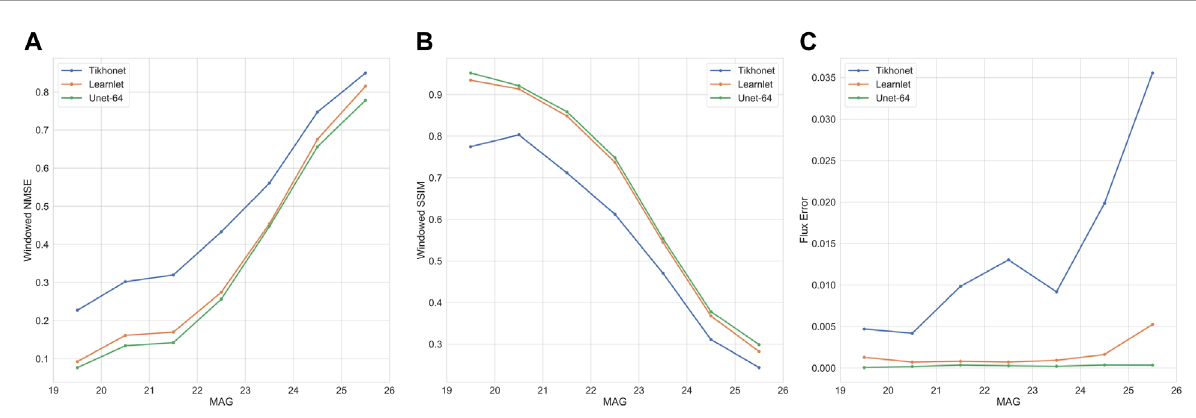
FIGURE 5 (A) Windowed NMSE as a function of the Magnitude (MAG), (B) Windowed SSIM as a function of MAG. An SSIM of 1 implies that the images are identical. (C) The Flux Error as a function of MAG. Unet-64 generalizes very well to the entire range of magnitudes.